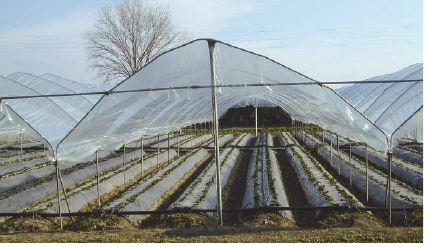
Figure 1: Plastic-covered tunnel with inside plastic soil